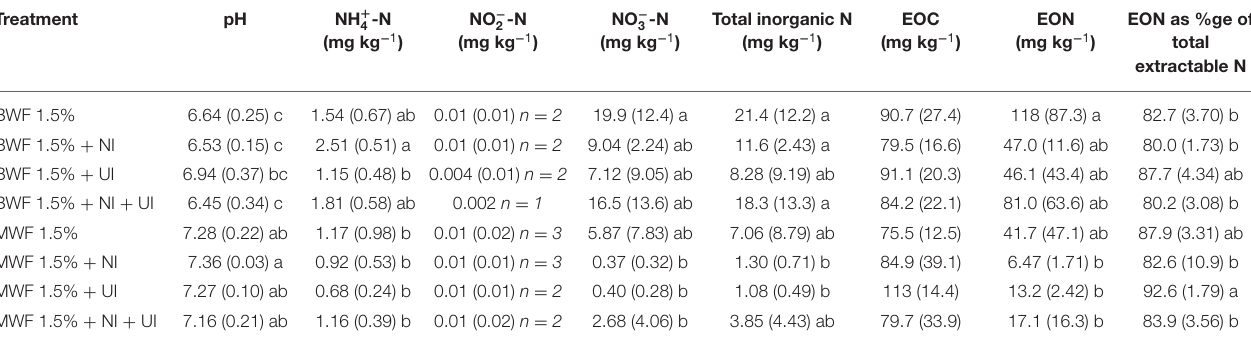
TABLE 3 | Substrate pH, ammonium (NH + 4 -N), nitrite (NO 2 -N), nitrate (NO − 3 -N), total inorganic N, extractable organic C (EOC) and N (EON) and EON as a percentage of total extractable N, at the end of the experiment (mean ± standard deviation for n = 5 except where indicated). Treatment